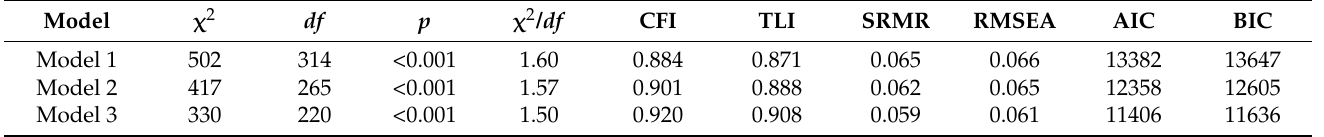
Table 4. Comparison between fit indexes deriving from CFA of the five-factor model.